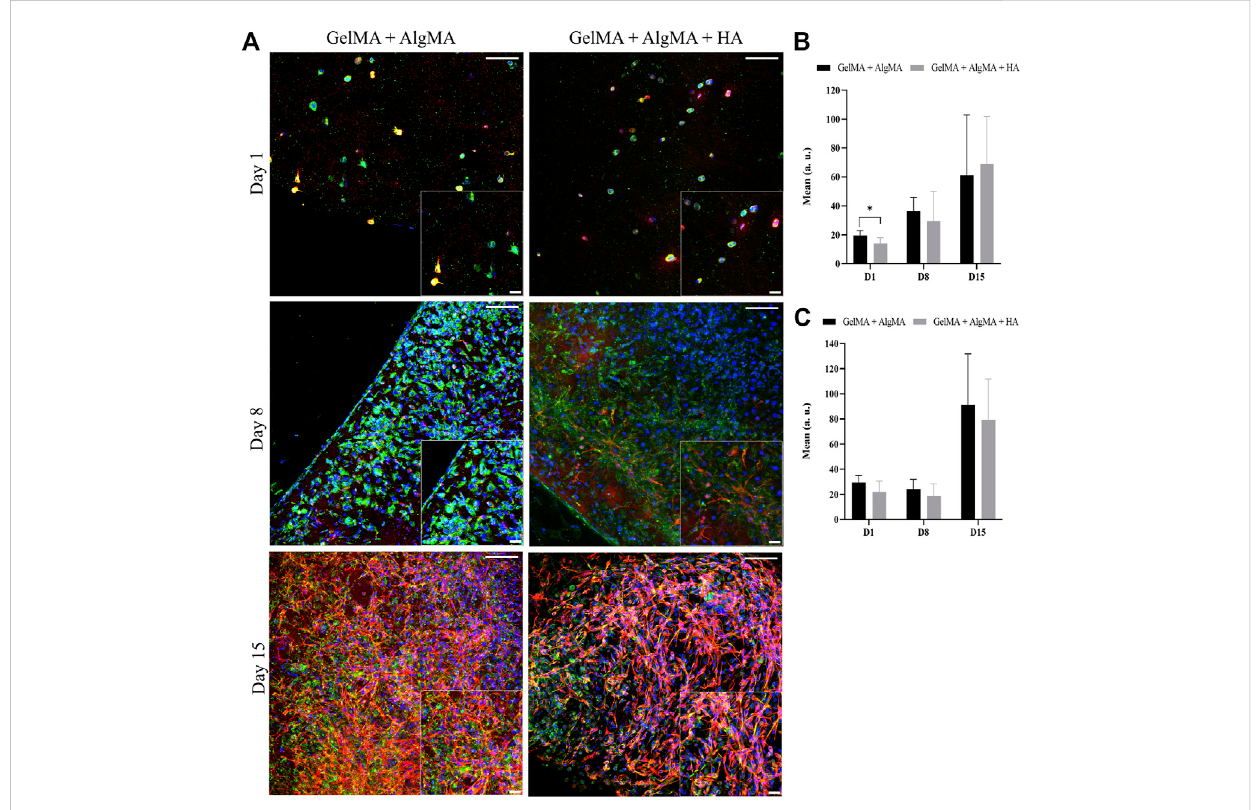
FIGURE 8 Evaluation of the differentiation of C17.2 cells embedded in the hydrogel after printing for up to 15 days. (A) Representative confocal images of immuno fl uorescence assay progenitor marker nestinis stained in green, neuron marker β -III tubulin is stained in red, and nuclei are stained in blue (scale bar100 µm).Localzoomimagesareplacedatthebottomrightcornerofeachimagewithascale barof30 µm.Quanti fi cationofthemeanexpressionof nestin (B) and β -III tubulin (C) . Data are presented as mean ± standard deviation. Statistical signi fi cance was calculated using a two-way